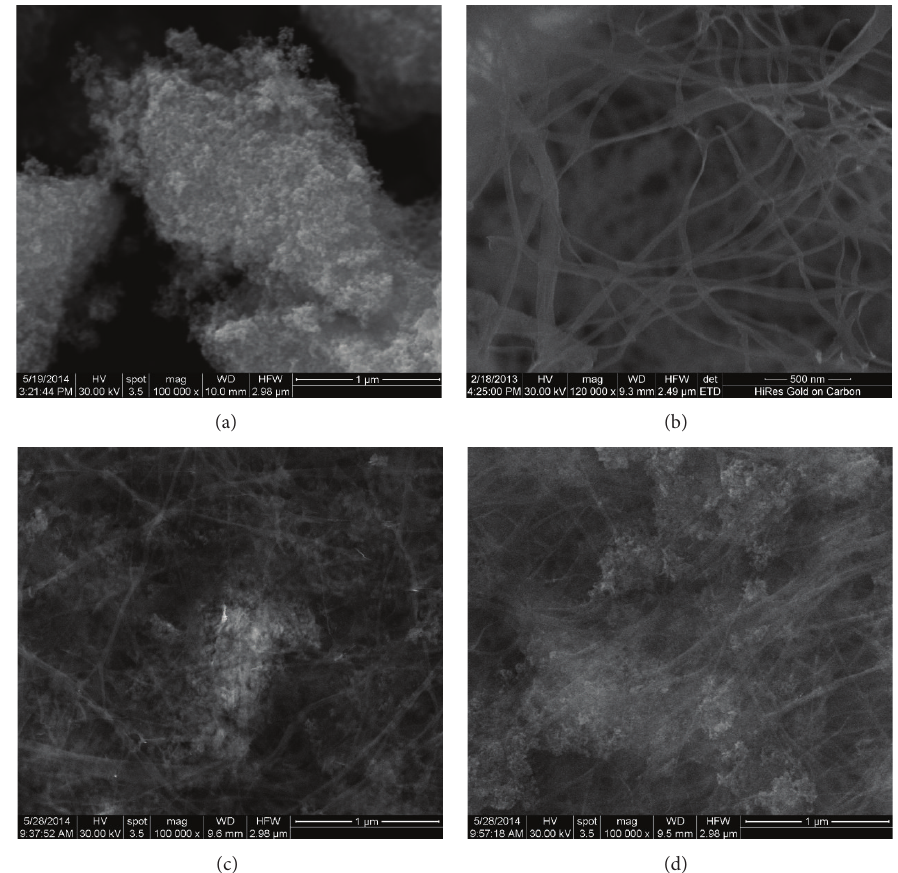
Figure 3: SEM microphotographs of pure magnetite nanoparticles (a), bacterial cellulose (b), nanocomposite with 1% magnetite (c), and 5% magnetite